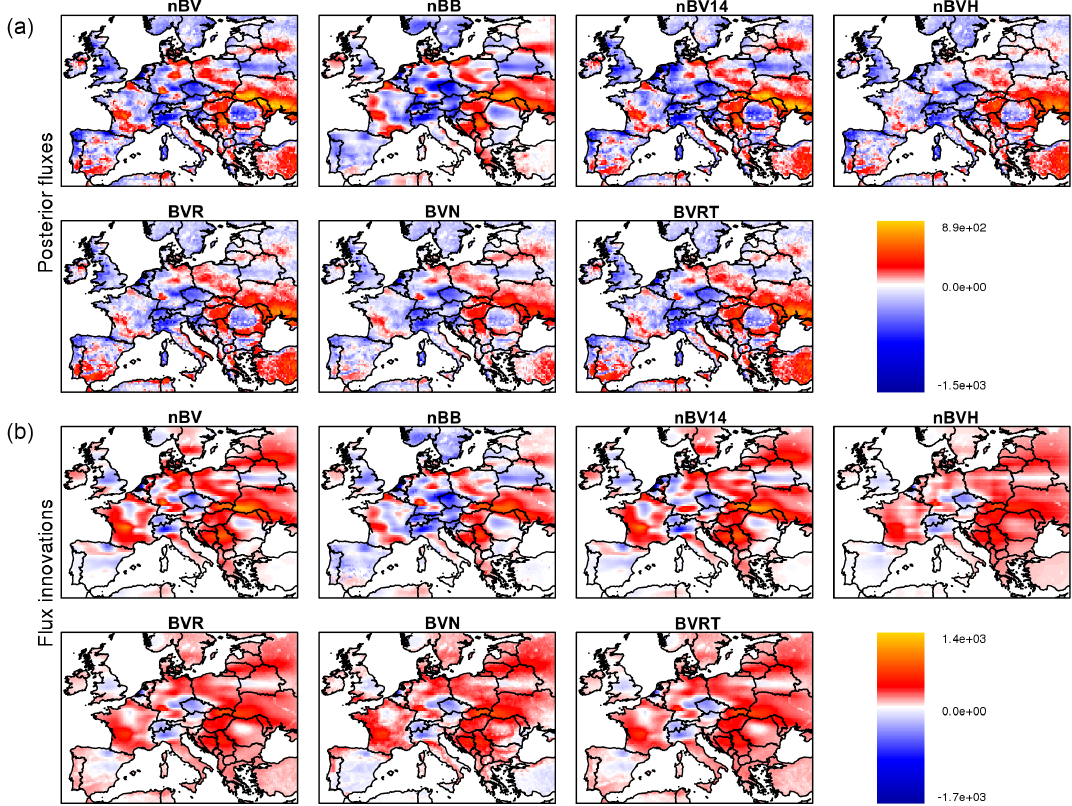
Figure 3. Annual biogenic flux spatial distribution (a) and flux innovations (posterior minus prior, b ) as estimated from the different inver- sions for the real-data case. Units are in gCyr − 1 m − 2